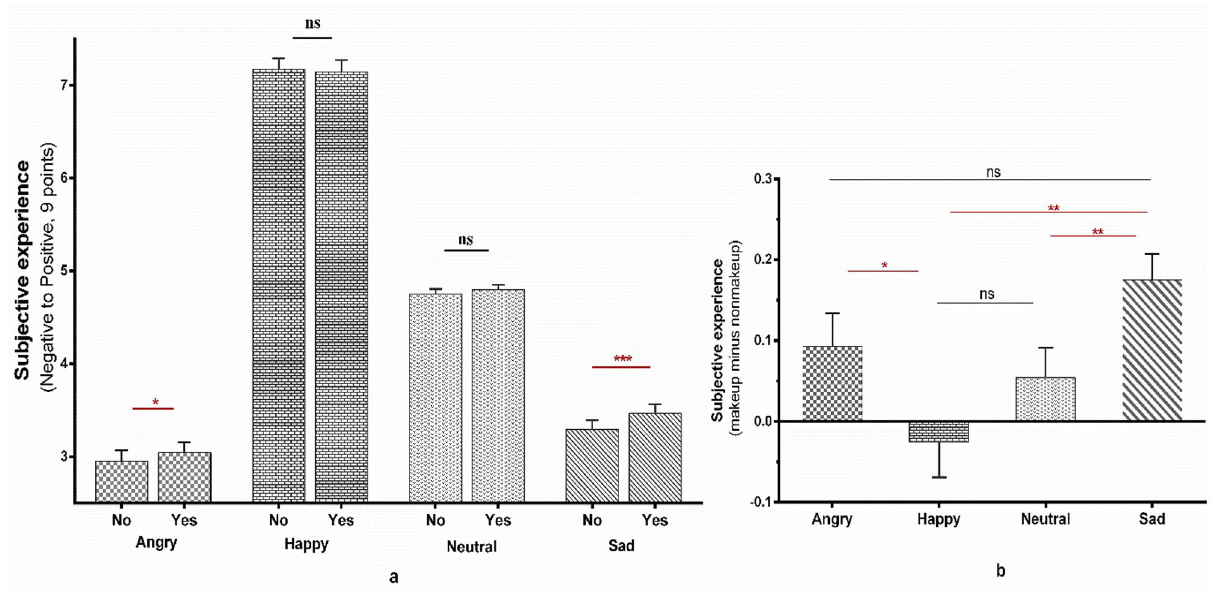
Figure 3. The effect of makeup on emotional contagion in Experiment 1. ( a ) The effect of makeup on different emotional contagion. “Yes” refers to makeup conditions, and “No” indicated non-makeup conditions. ( b ) The differences in increments induced by makeup among emotions. The error bar represents standard error. “*” p < 0.05, “**” p < 0.01, “***” p < 0.001.